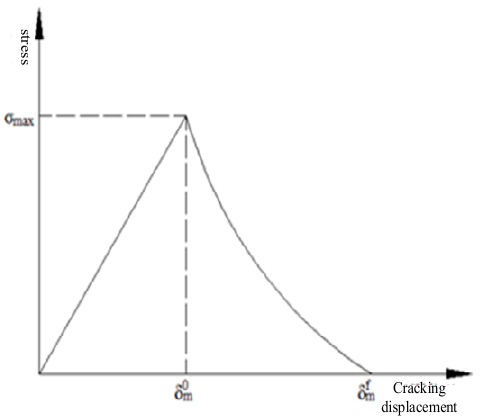
Figure 1. Tension relationship of exponential model.